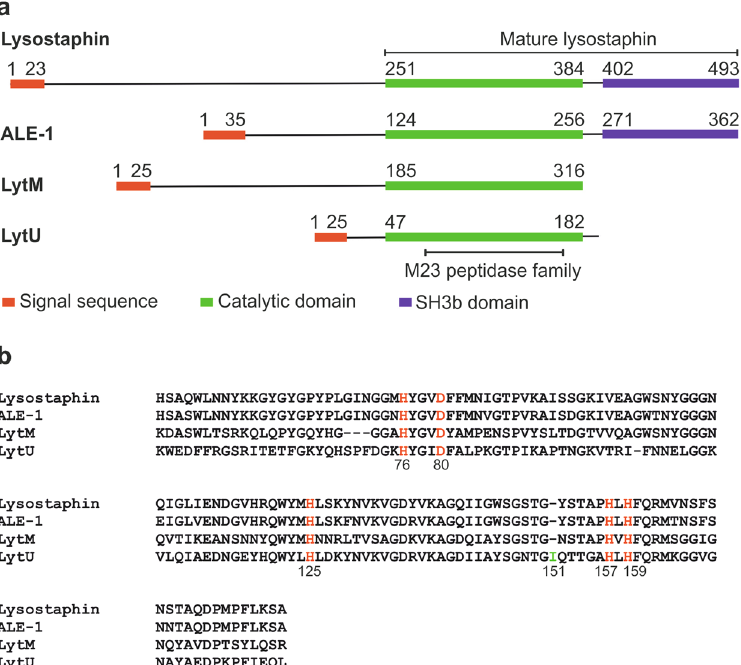
Figure 1. Comparison of M23 endopeptidase amino acid sequences. ( a ) Comparison of full-length lysostaphin, ALE-1, LytM, and LytU. N-termini of all proteins begin with a signal sequence that directs them to the cellular membrane and outward of the cytoplasm. The enzymes have unique N-domains (those for ALE-1 and lysostaphin are analogous, consisting of tandem 13 amino acid length repeats), for which functions remain unknown. The N-domain may need to be cleaved off for the enzymatic activity of catalytic domain (as for LytM, the activating in vivo enzyme is unknown 20 ), need not be cleaved off (ALE-1 17 ), or the enzyme may increase activity upon cleavage (4.5-fold for lysostaphin 21 ). Lysostaphin and ALE-1 possess, while autolytic LytM lacks SH3b domain downstream their catalytic domains to target extracellular substrates 20, 42, 43 . Structural predictions for LytU were made using SignalP 44 , HMMTOP 45 and MODELLER 46 . Signal sequences are marked as indicated in the UniProt database, except for LytU sequence, which was predicted using SignalP 44 . ( b ) Alignment of the catalytic domains with ClustalW 47 . Conserved residues involved in zinc ion coordination (H76, D80 and H159) and catalytic (H125 and H157) are marked in red. The LytU unique insertion is highlighted in green and can be lysine in some S. aureus